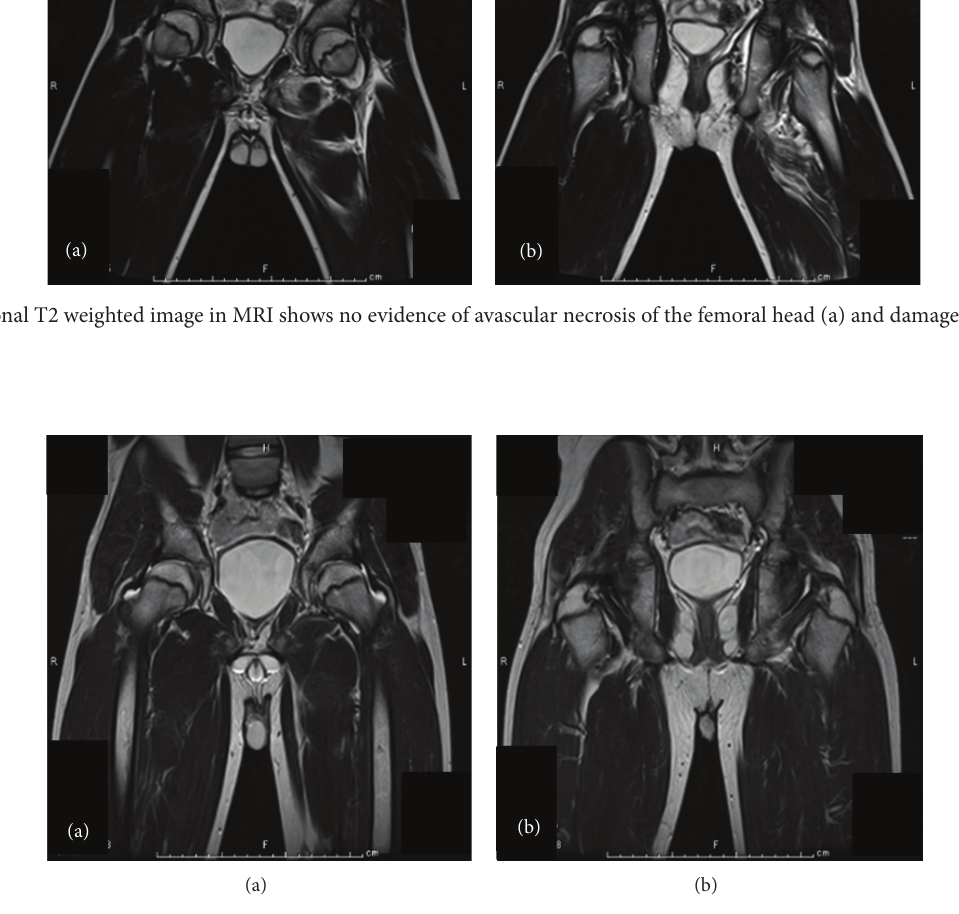
Figure 5: Coronal T2 weighted image in MRI shows no evidence of avascular necrosis of the femoral head (a) and healing of soft tissue damage (b) at 6